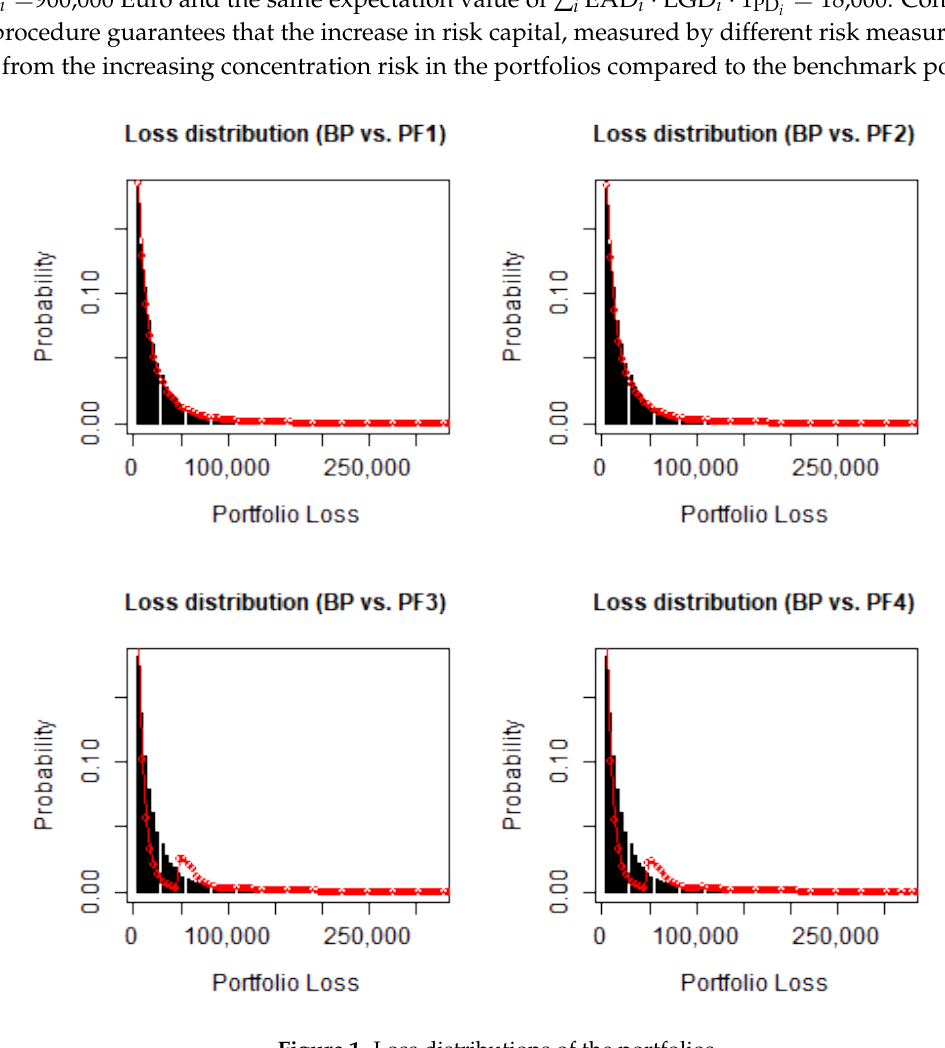
Figure 1. Loss distributions of the